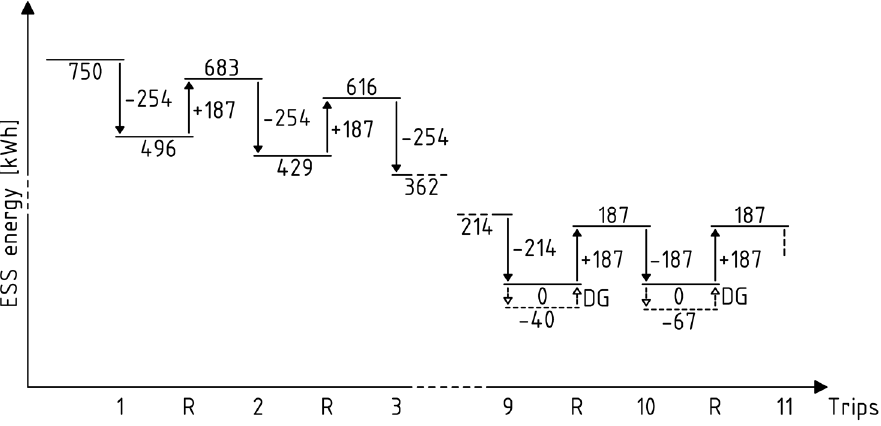
Figure 5. Energy stored in the ESS, consumption and recharge (R) during a working day, double MV-SC (case (d).